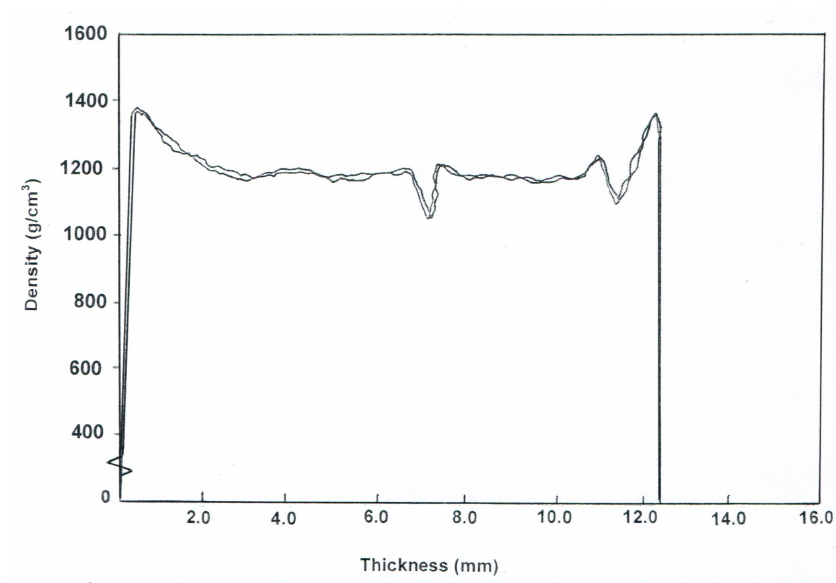
Figure 6. Density profile of oak veneered sample.